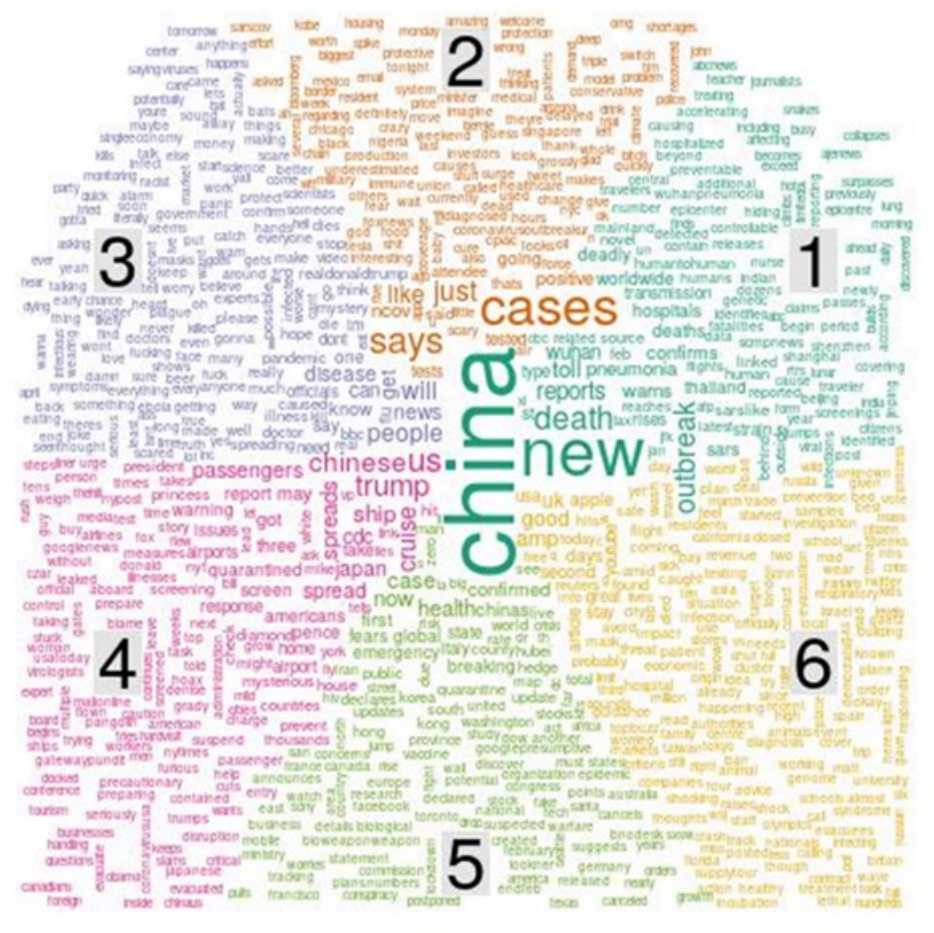
Figure 11. Word cloud showing the frequency of words associated with six identified topics: (1) reports on deadly pneumonia new cases and deaths of coronavirus outbreak from China; (2) the epidemic situation and confirmed cases of COVID-19; (3) knowledge about COVID-19 obtained from news reports; (4) the spread of COVID-19 from overseas to the US and how to control the disease; (5) health concerns and fear as COVID-19 is declared an emergency worldwide; (6) news and information reports on social media about the